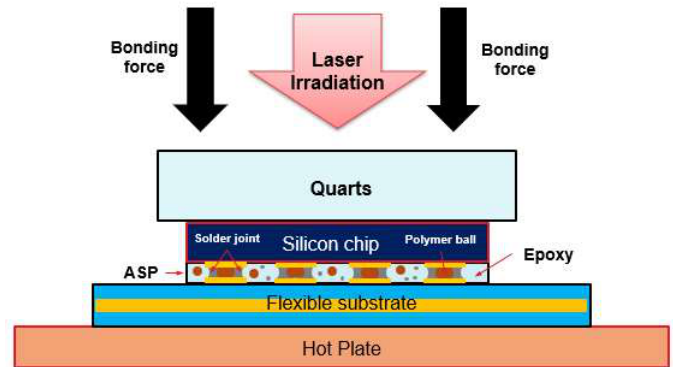
Figure 3. Schematic illustration of the laser bonding process of the flexible package.